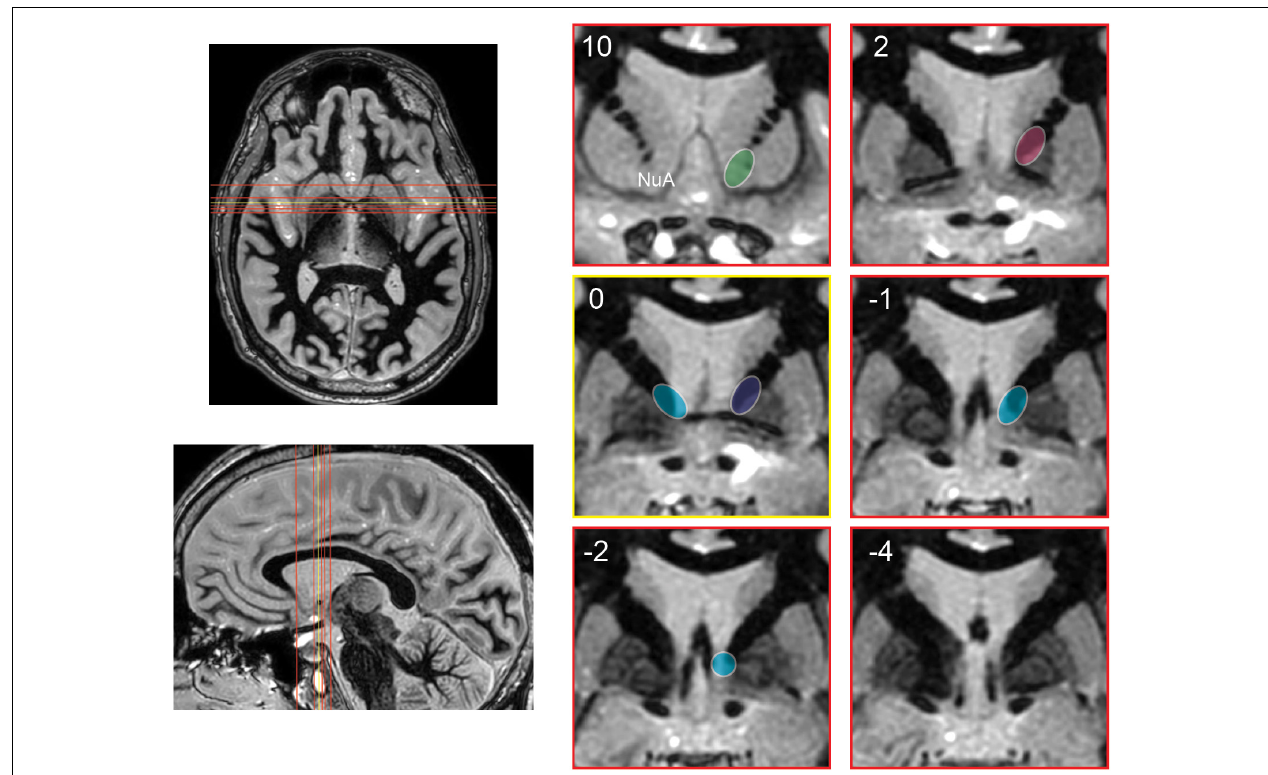
FIGURE 4 | Schematic representation of the evolution of stimulation targets posteriorly over time. Axial and sagittal images depict position of coronal slices (red) relative to anterior commissure (yellow). Coronal images are shown at 10 and 2 mm anterior to the anterior commissure, at the anterior commissure, and 1, 2, and 4 mm posterior to the anterior commissure. Approximate stimulation targets are shown for various studies, emphasizing the posterior progression of stimulation targets. Nuttin et al. (1999, 2003) (green). Greenberg et al. (2010): early cohort (pink), late cohort (blue). Luyten et al. (2016) and Raymaekers et al. (2017): targets with greatest stimulation effect (teal). NuA, nucleus